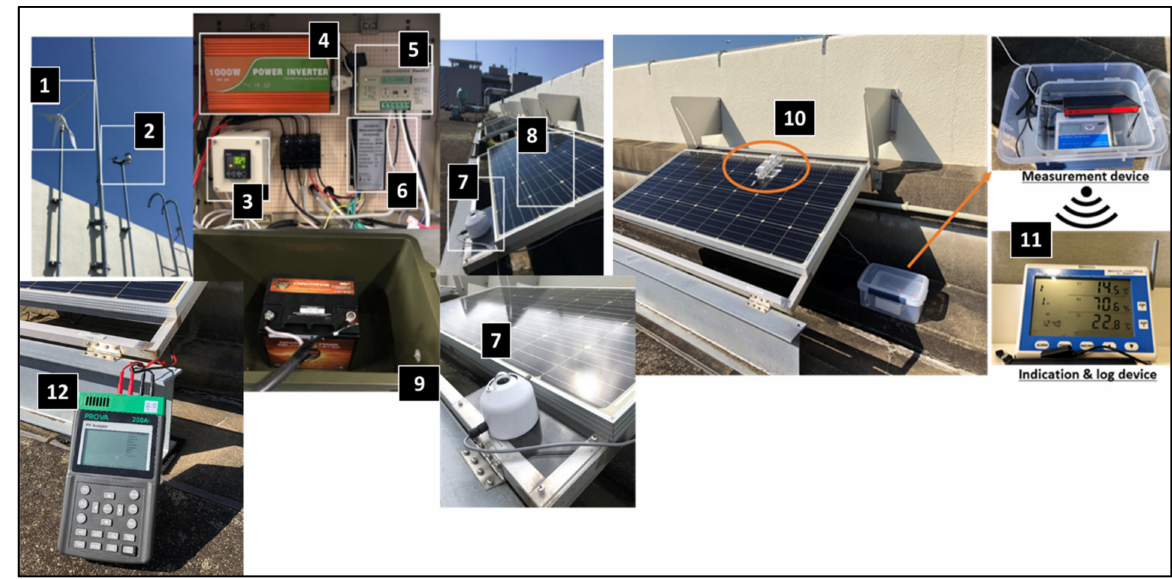
Figure 17. Experimental setup in this study: (1) wind turbine, (2) weather measurement station, (3) power datalogger, (4) inverter, (5) PV DC converter and MPPT controller, (6) wind DC converter and MPPT controller, (7) MS-40C pyranometer, (8) PV modules, (9) battery, (10) LM335 thermocouple, (11) temperature datalogger, (12) solar analyzer PROVA